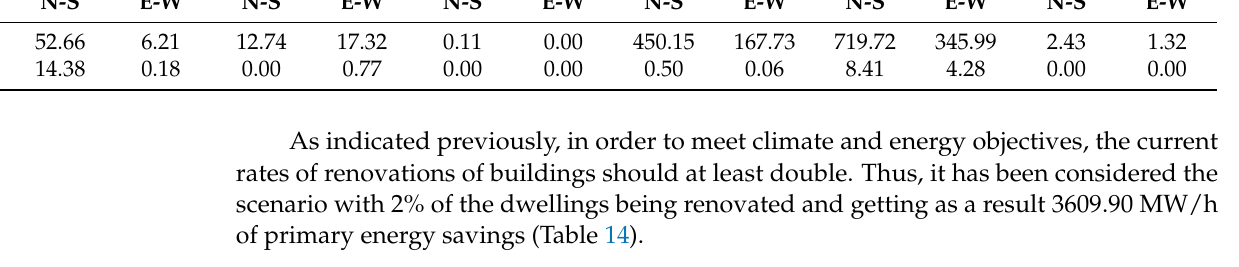
Table 13. Total primary energy savings per year (MW/h) of 1% of EVha building stock. SFH1 SFH2 SFH3 MFH1 MFH2